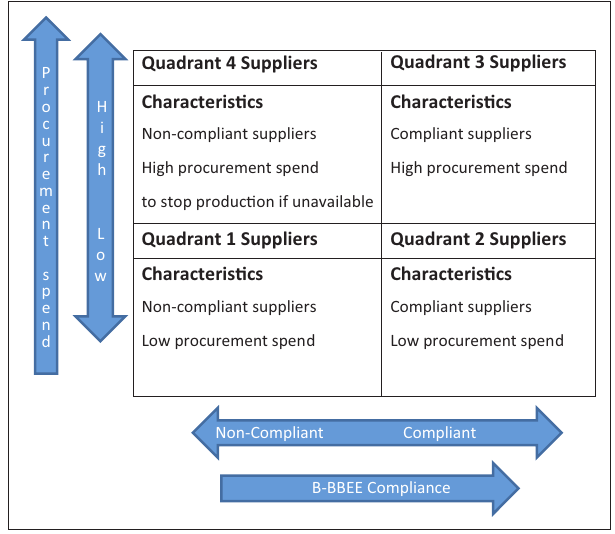
FIGURE 2: Proposed supplier segmentation for supplier